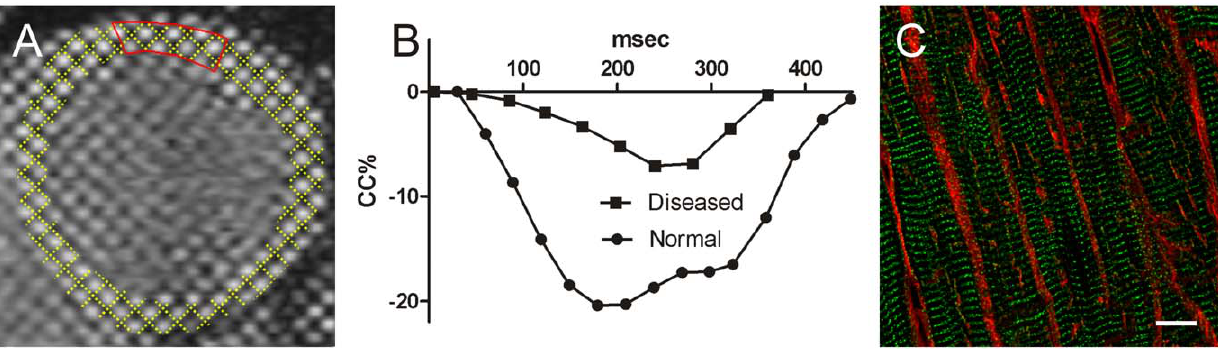
Figure 1. Panel A shows tagged MRI short axis image through the middle of a failing heart in end diastole. Tracked grids are shown as yellow overlay with sampled region marked in red. Panel B shows circumferential shortening (CC%) of the region indicated in the panel A compared to a similar region in normal human heart. Panel C shows RyRs (green) and WGA (red) labeling of diseased myocytes from the region shown in panel A. Image is z projections of 10 slices with z depth of 2.5 m m from deconvolved image stack. Scale bar is 10 m